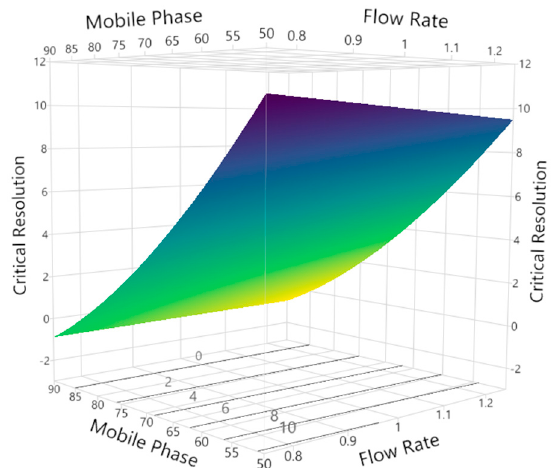
Figure 7. Three-dimensional response surface plot for the effect of flow rate (X 1 ) and mobile phase composition (X 2 ) on critical resolution (DSF and impurity).